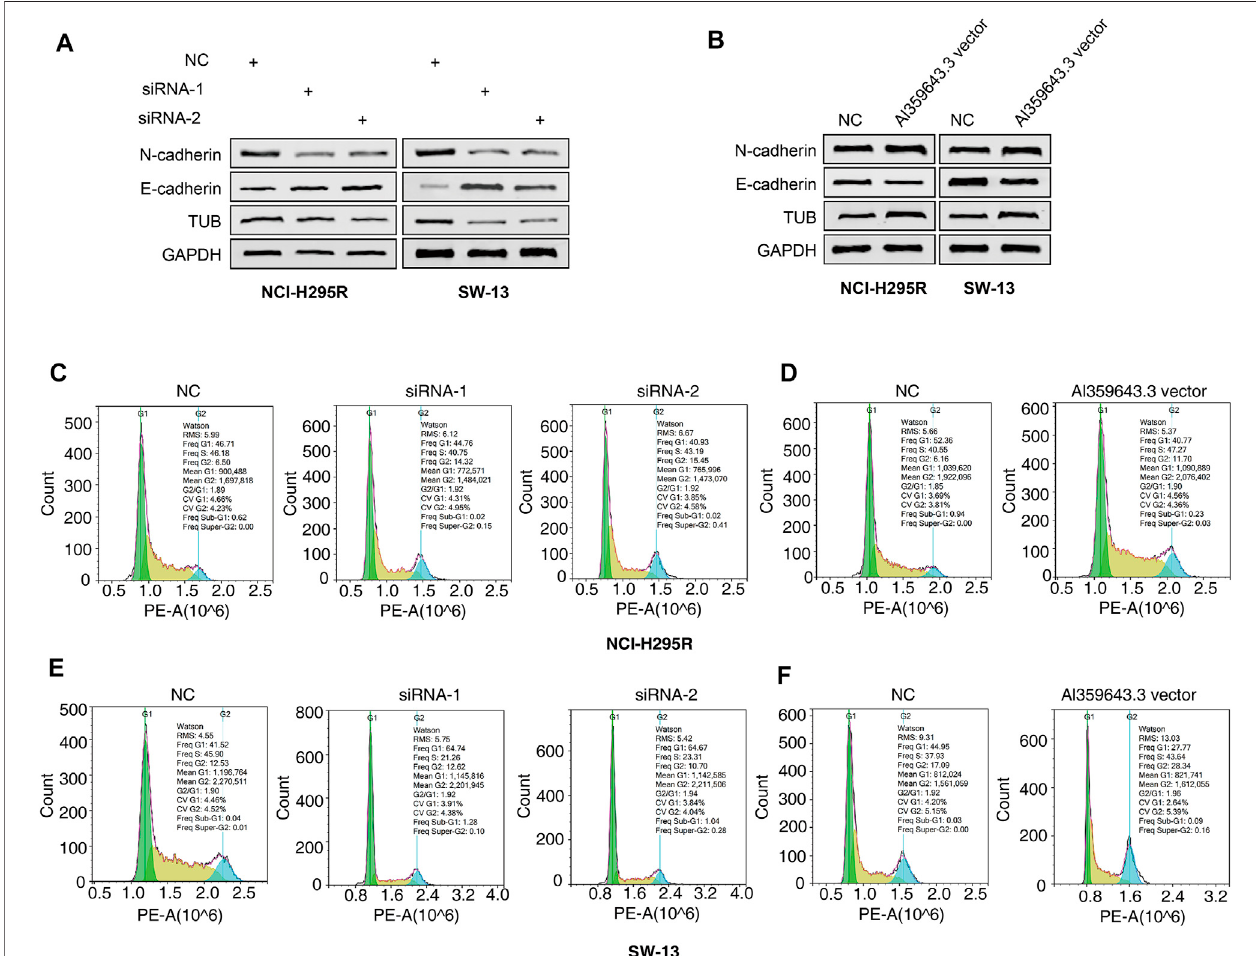
FIGURE 9 | Effects of AL359643.3 on cell cycle and the expression of EMT-associated proteins. (A,B) Western blots of EMT-associated proteins with AL359643.3 knock-down (A) or overexpression (B) in both NCI-H295 and SW-13 cells. (C,D) Cell cycle progression detection with AL359643.3 knock-down (C) or overexpression (D) in NCI-H295 cells. (E,F) Cell cycle progression detection with AL359643.3 knock-down (E) or overexpression (F) in SW-13 cells.